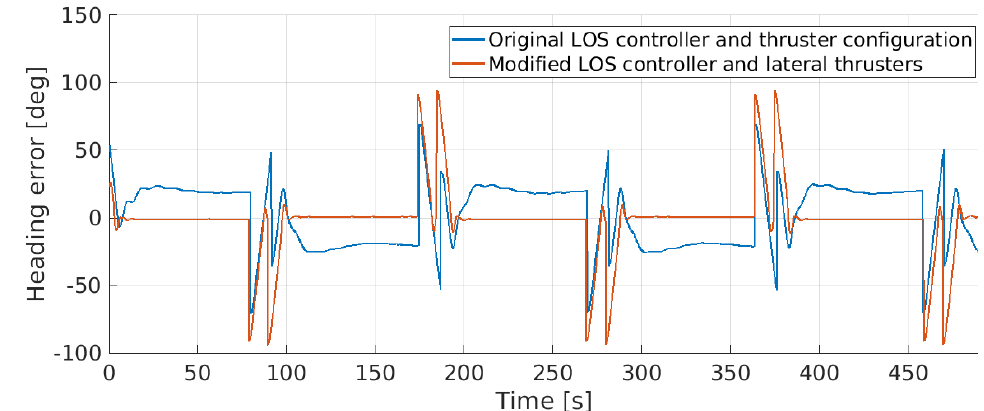
Figure 19. Simulation results for heading error during lawn mower pattern path following employing the vehicle’s original configuration—SPARUS II and the modified